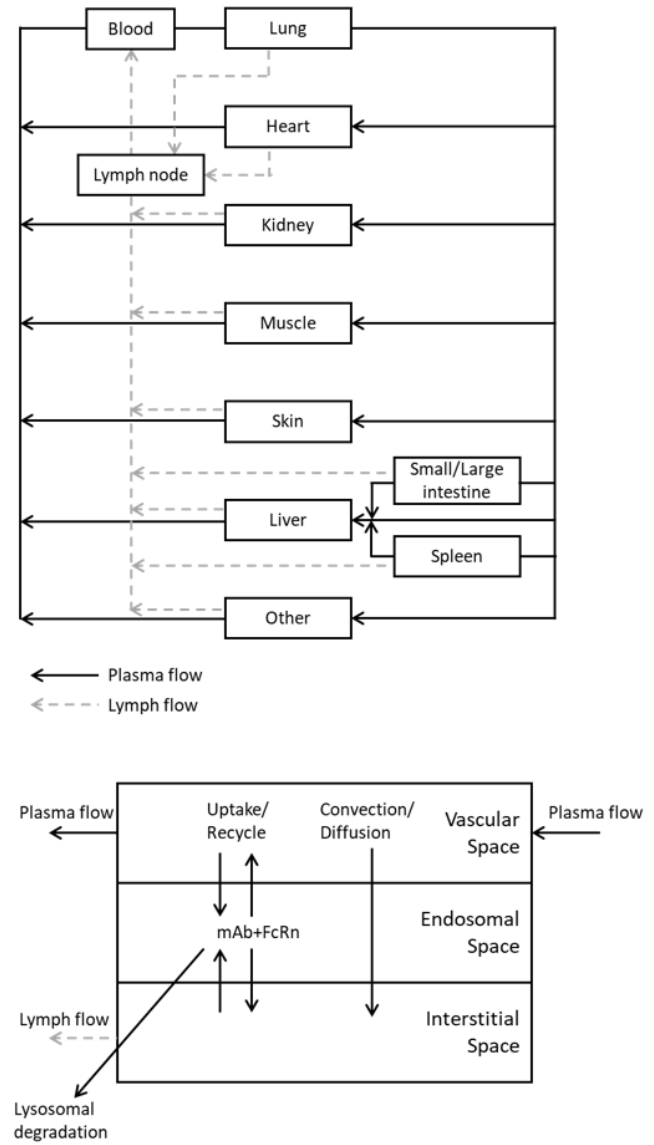
Figure 2. Schematic representation of the PBPK model.